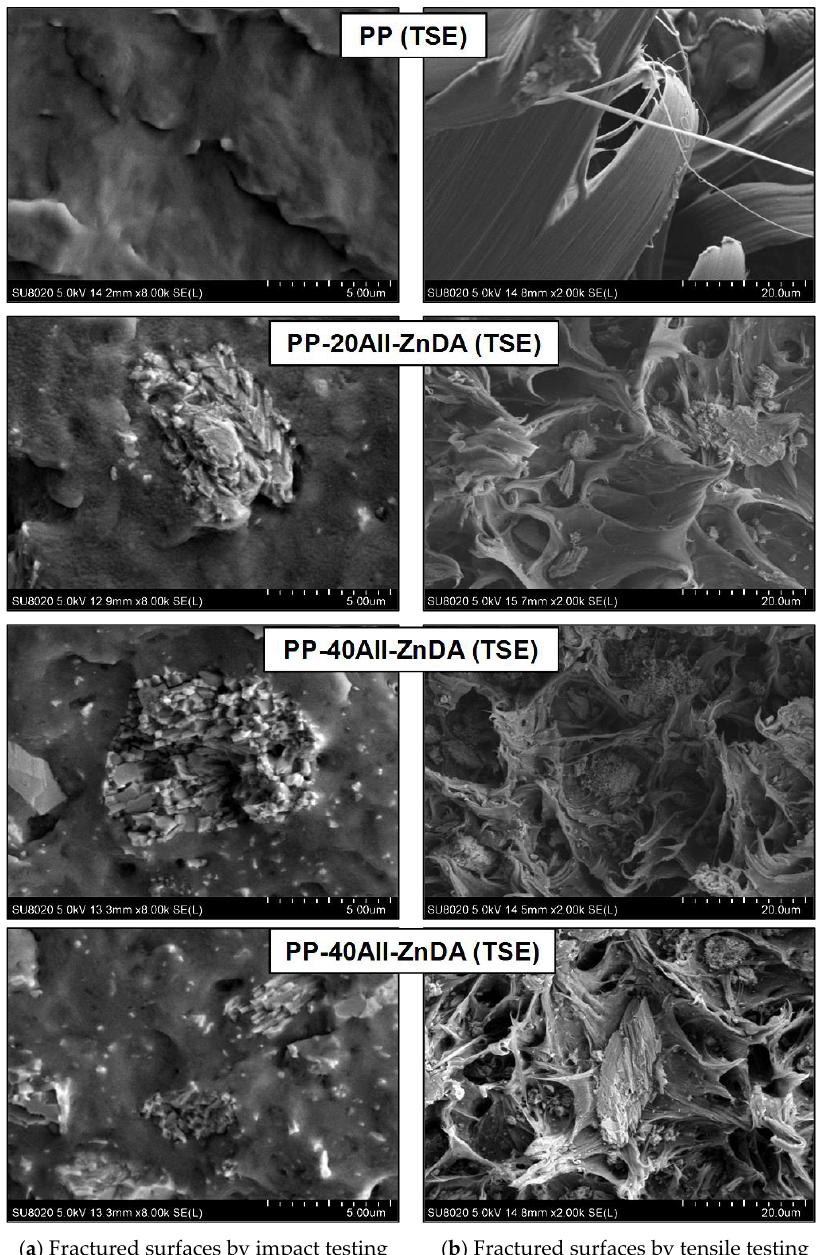
Figure 11. ( a , b ) SEM images (SE mode) of PP and PP – AII – ZnDA (TSE) composites performed on the fractured surfaces obtained by: ( a ) impact (left side) and ( b ) tensile testing. On the other hand, regarding the specimens fractured at lower speed by tensile test- ing (Figure 11b), together with the evidence of ductile/plastic deformation specific to PP,